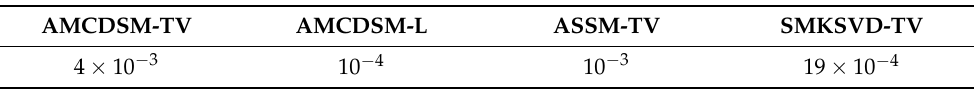
Table 4. Optimal values of lambda for AMCDSM-TV, AMCDSM-L, ASSM-TV, and the proposed SMKSVD-TV